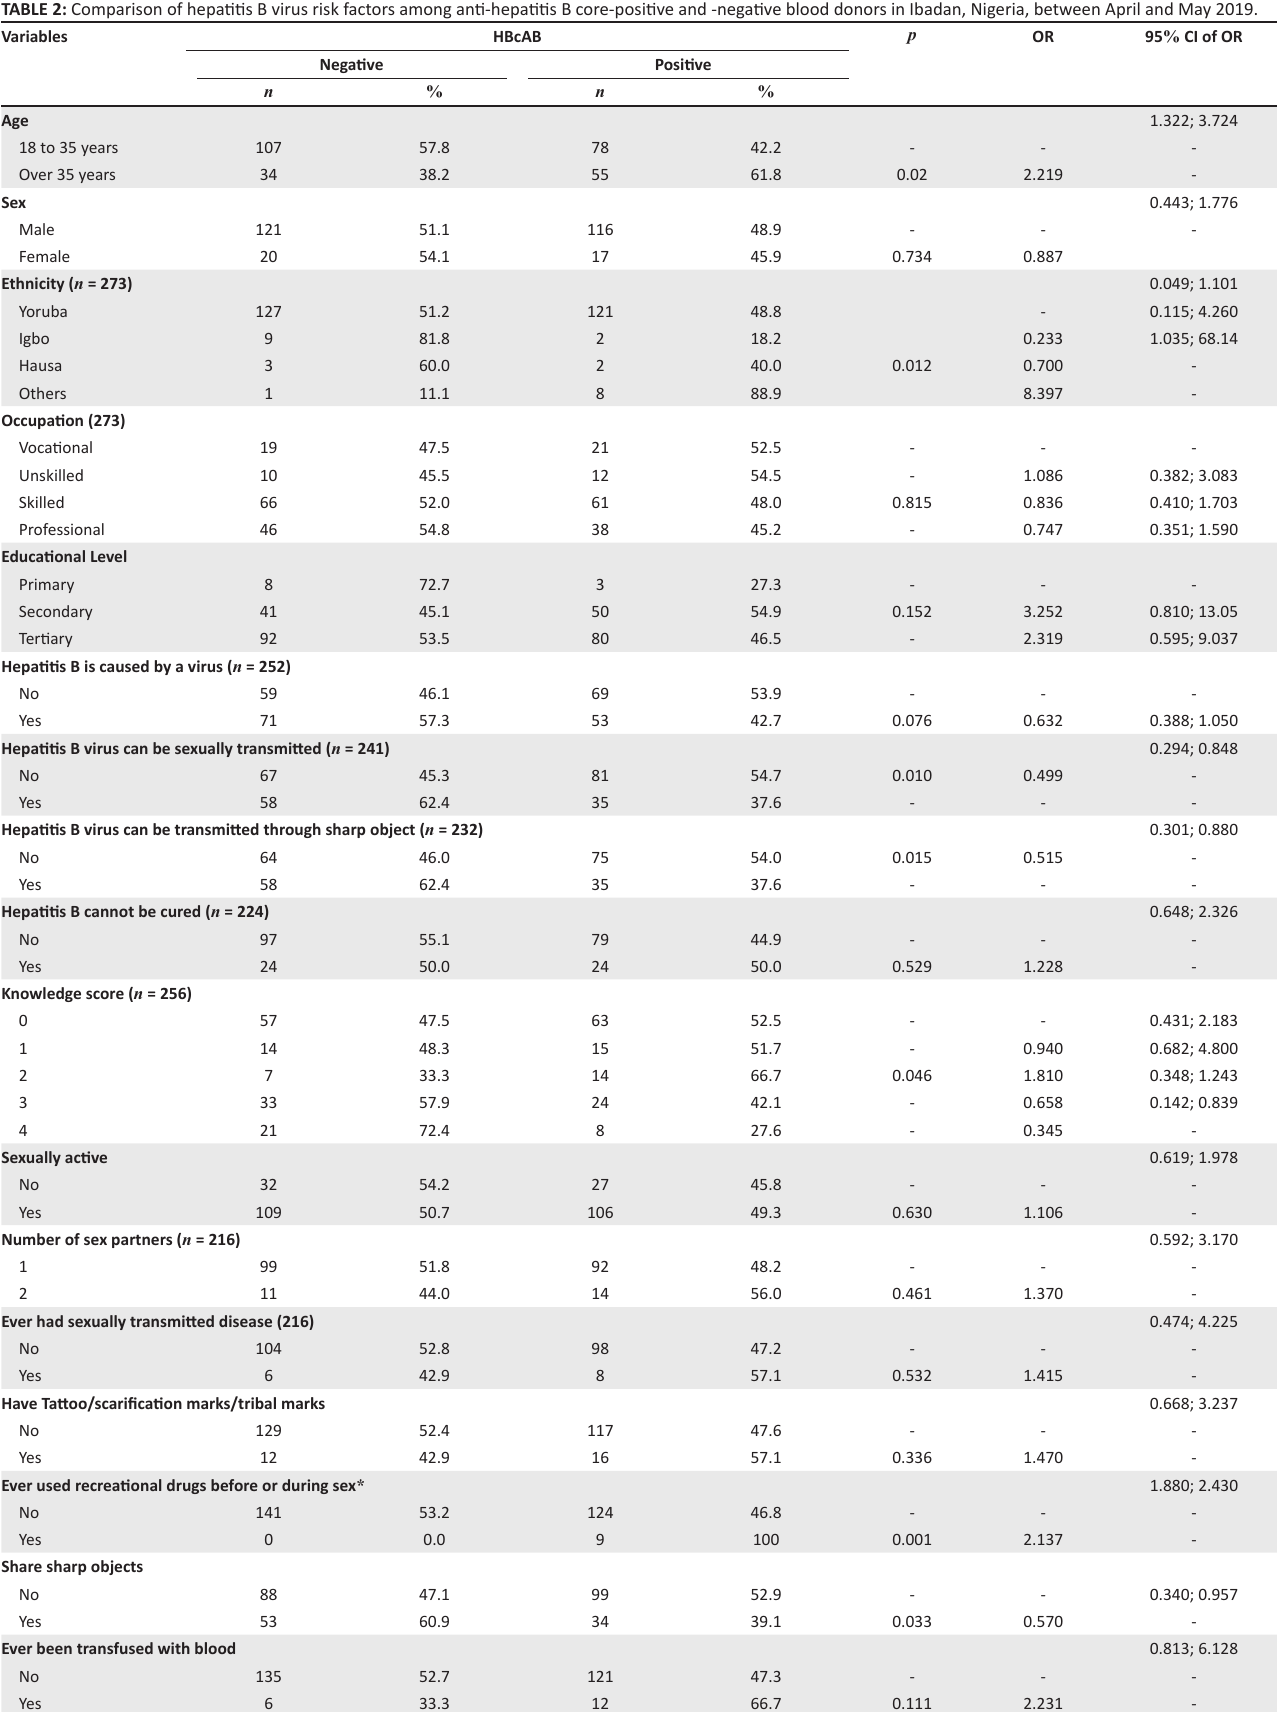
TABLE 2: Comparison of hepatitis B virus risk factors among anti-hepatitis B core-positive and -negative blood donors in Ibadan, Nigeria, between April and May 2019. Variables HBcAB p